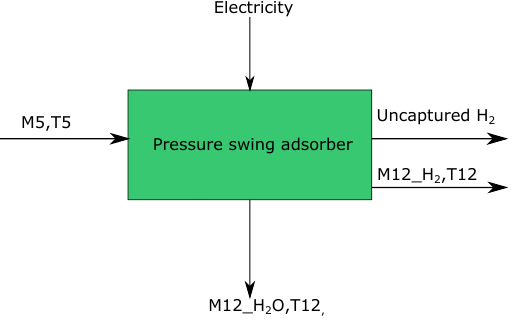
Figure 7. Mass and energy flow through the waste gas separation unit.